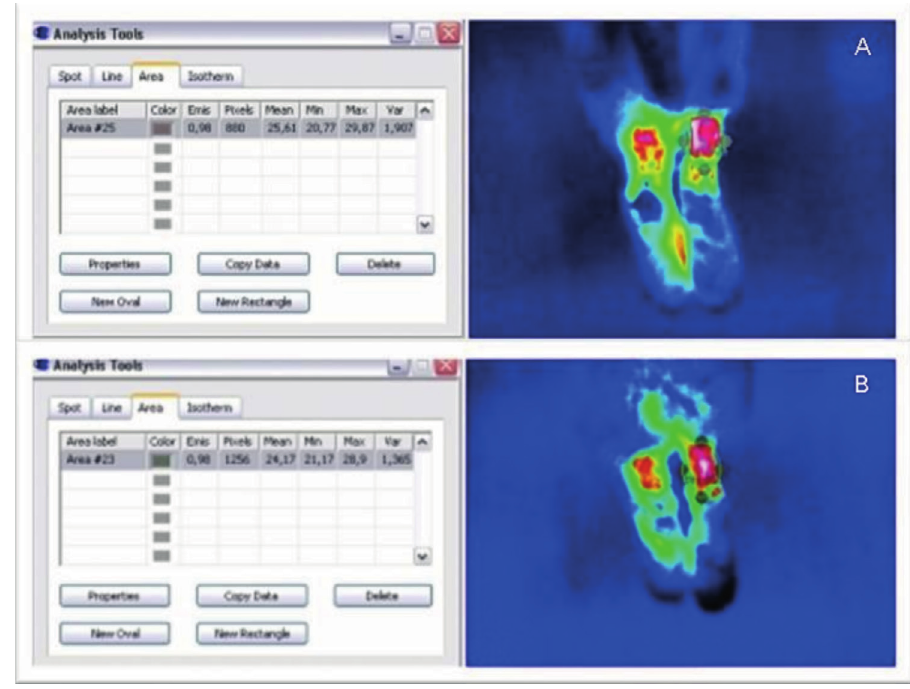
Figure 2 - A) Thermographic analysis MTT: Brazil suture – 15 th day. B) Thermographic analysis MTT: Brazil suture – 30 th day Source: Laboratory of Experimental Surgery, Institute of Orthopedics and Traumatology, Passo Fundo, RS – Brazil.